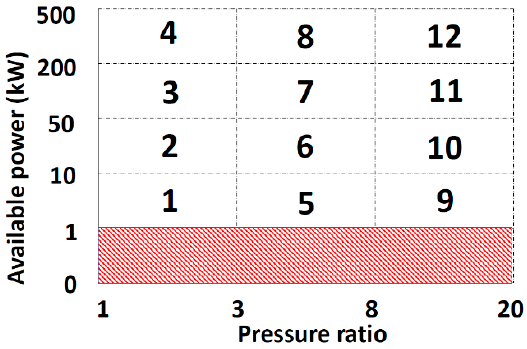
Figure 2. Cumulative percentage distribution of the number of pressure reduction stations (PRSs) (included in the available sample) against ( a ) annual-averaged available mechanical power and ( b ) pressure ratio of the processed natural gas.